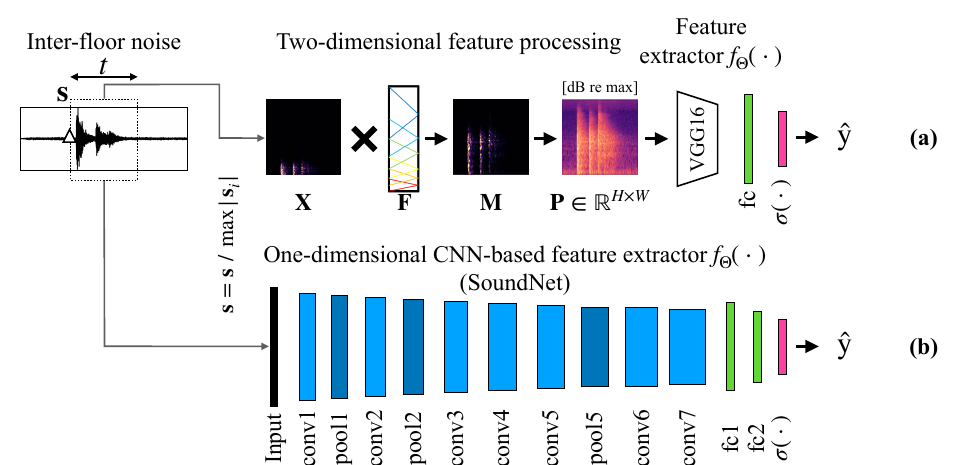
Figure 4. A flow of the inter-floor noise classification. ( a ) A signal from a detected onset position ( (cid:52) ) s is converted to a log-scaled Mel-spectrogram P . P is provided to the three input channel of the feature extractor f Θ ( · ) then pseudo probabilities of categories in a label space for a given input ˆ y are predicted. ( b ) The one-dimensional CNN computes one-dimensional convolution directly on s and summarizes the